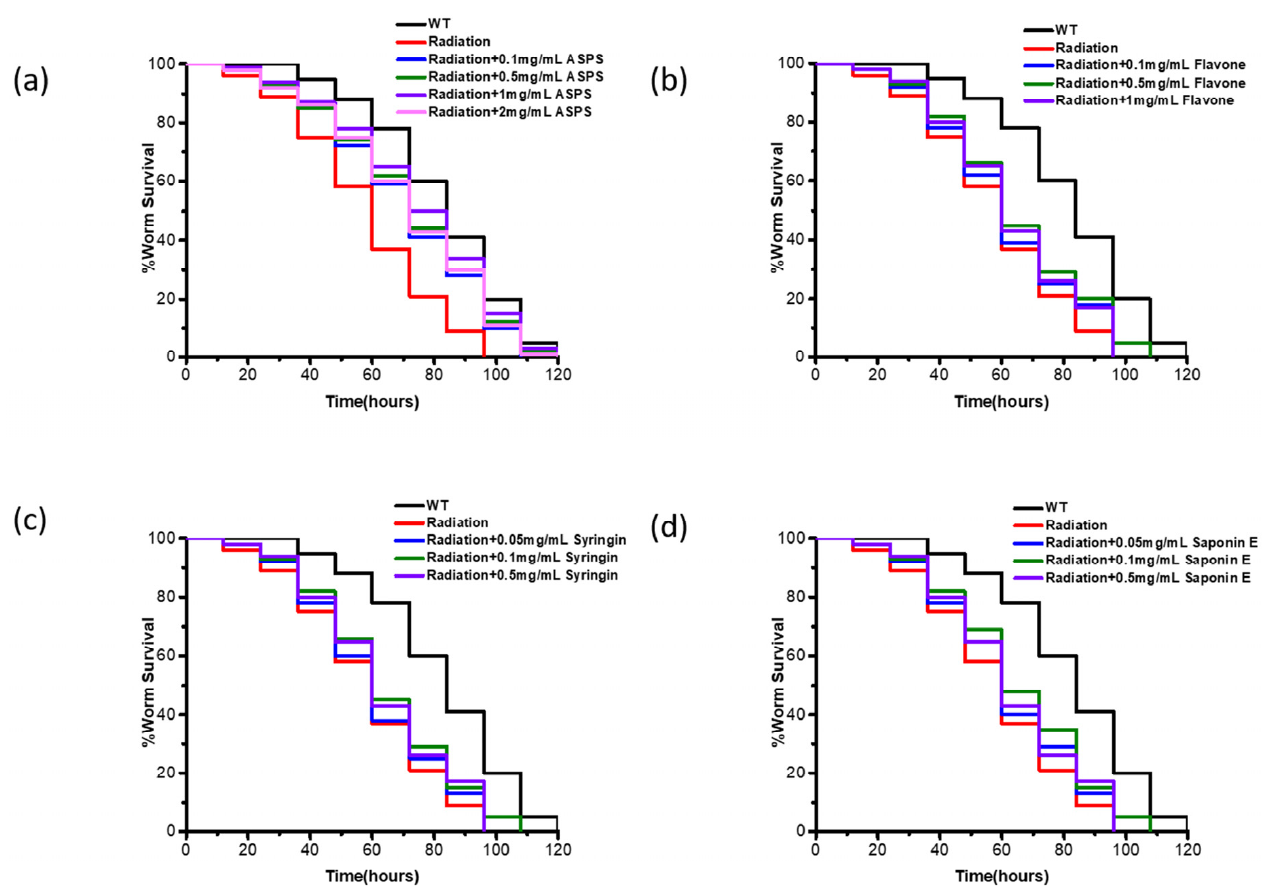
Figure 1. ASPS enhanced the pathogen resistance of radiation-damaged nematodes. ( a – d ) Survival curve of PA14-infected nematodes cultured with different concentrations of ASPS, flavonoids, sy- ringin, saponin E. 1mg/mL ASPS could significantly improve the survival of radiation-damaged nematodes. n = 3 biological replicates. p < 0.01 (log-rank test).